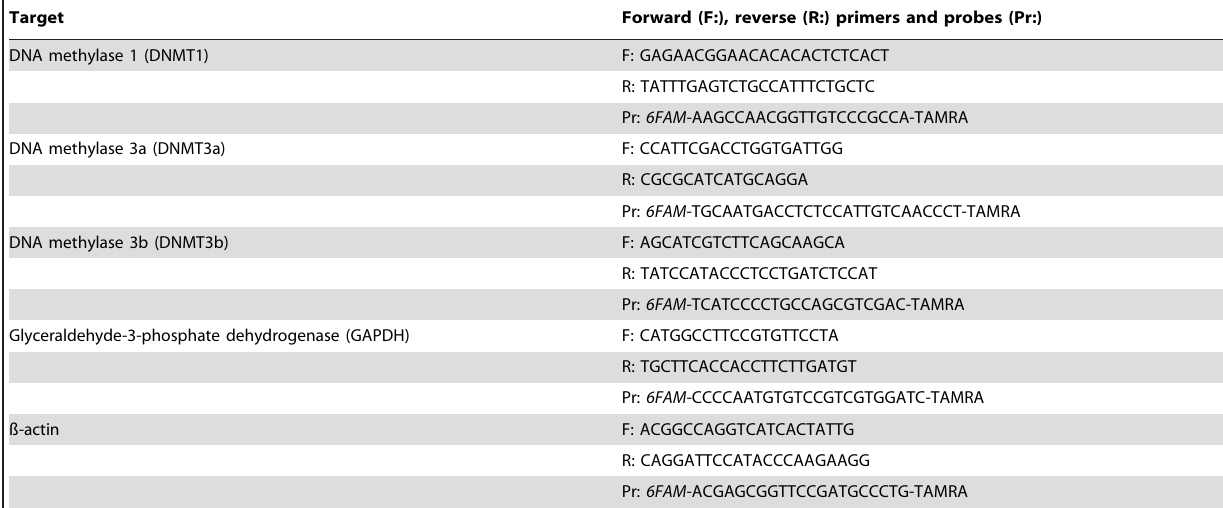
Table 2 . PCR primers and probes used for analysis of DNA methylases and as internal controls.